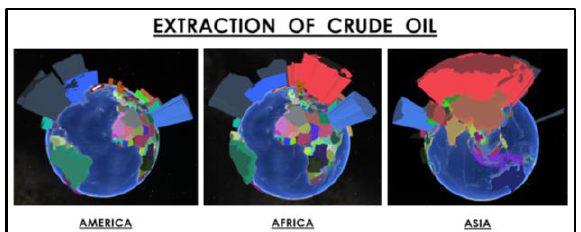
Figure 6. Capability to extract crude oil expressed in 3D extrusion on Google Earth Pro.